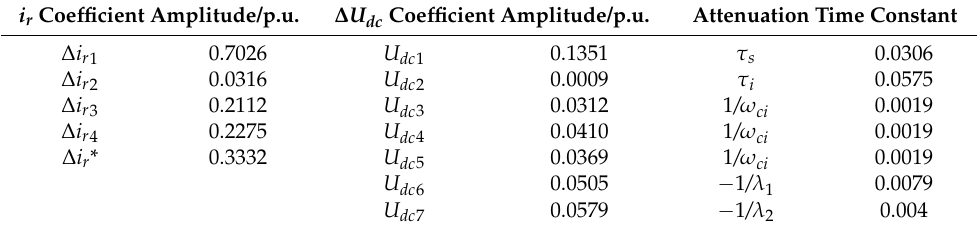
Table 1. Coefficient amplitudes and time constants of attenuation components in i r and ∆ U dc . i r Coefficient Amplitude/p.u. ∆ U dc Coefficient Amplitude/p.u. Attenuation Time Constant ∆ i r 1